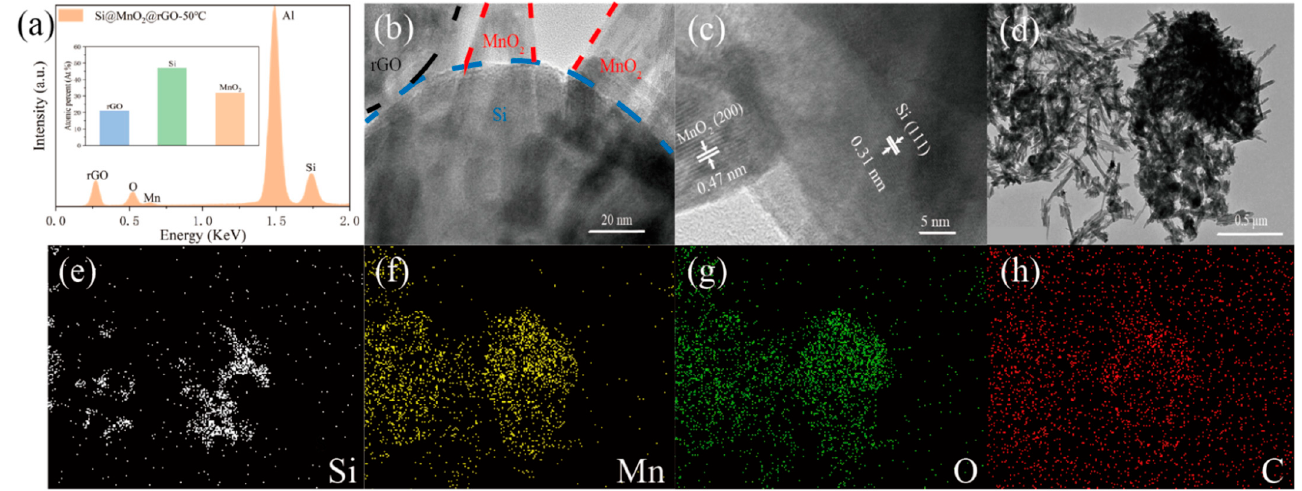
Figure 3. ( a ) Energy Dispersive Spectrometer (EDS) spectra of Si@MnO 2 @rGO-50°C. Inset showing the respective substance of Si@MnO 2 @rGO-50°C. ( b , c ) HRTEM images of the Si@MnO 2 @rGO-50°C composite at different magnifications. ( d – h ) Elemental mapping of the Si@MnO 2 @rGO-50°C composite.